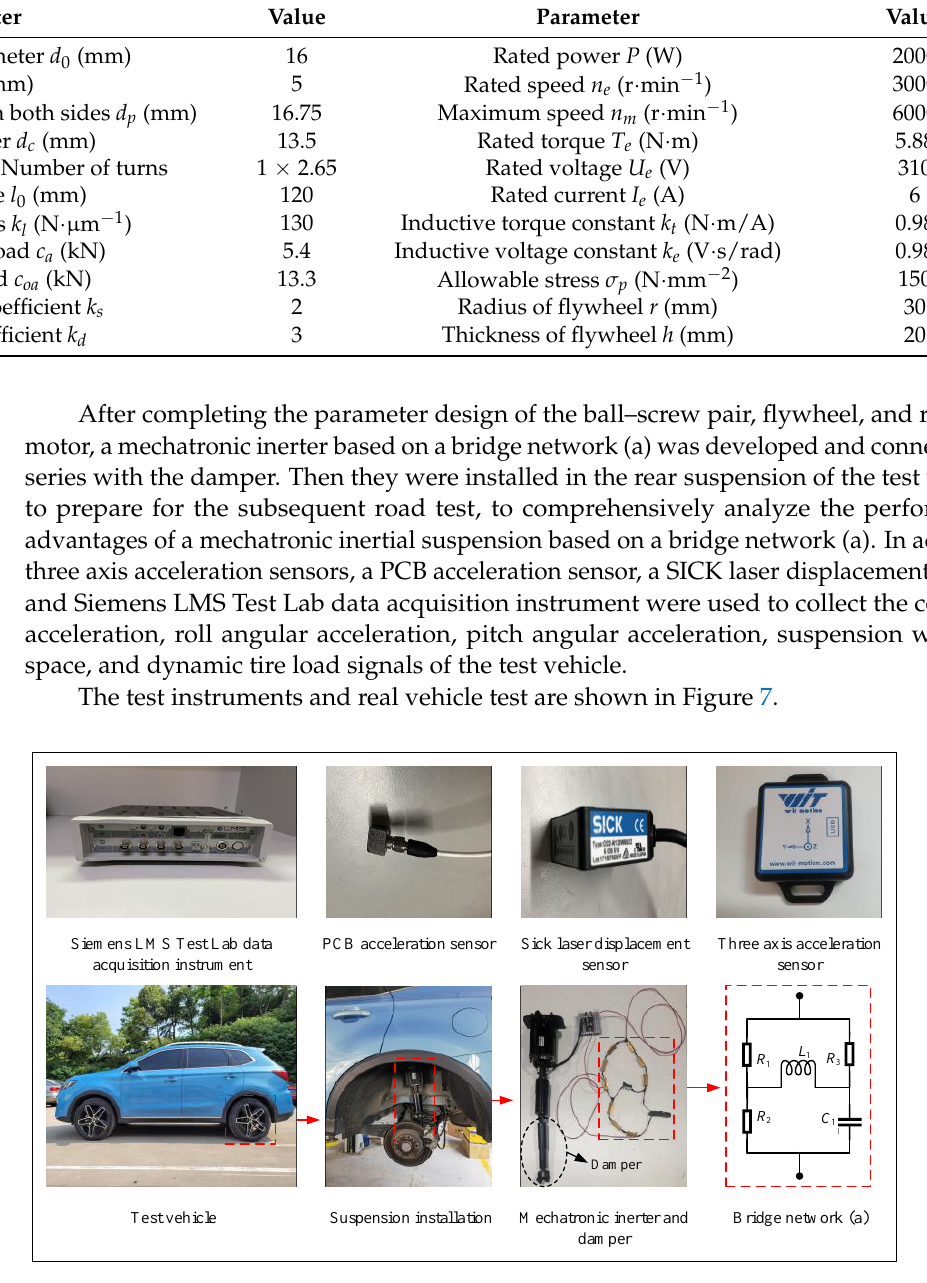
Figure 7. Test instruments and real vehicle test.